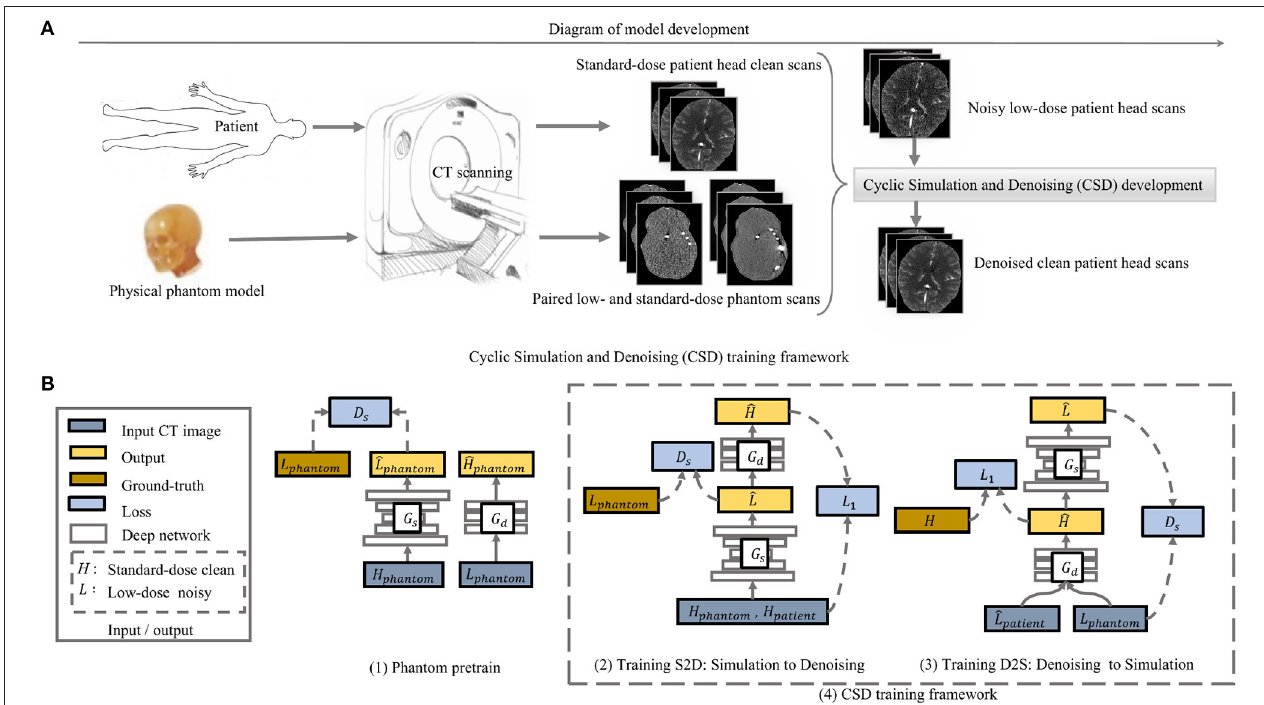
FIGURE 2 | The overview of the model development in (A) and the proposed cyclic simulation and denoising (CSD) training framework in (B) . (A) demonstrates how we incorporate a physical phantom model into the proposed deep learning model CSD. (B) shows how our CSD is developed in detail. Two training stages: first, we initialize the weights of simulator and denoiser by pretraining on physical phantom CT scan (1); second, the cycle-training from noise simulation to denoising (2) and another cycle-training from denoising to simulation (3) are developed simultaneously. The G s and G d represent simulation and denoising, separately. During training, the two cycles interact with each other and are executed